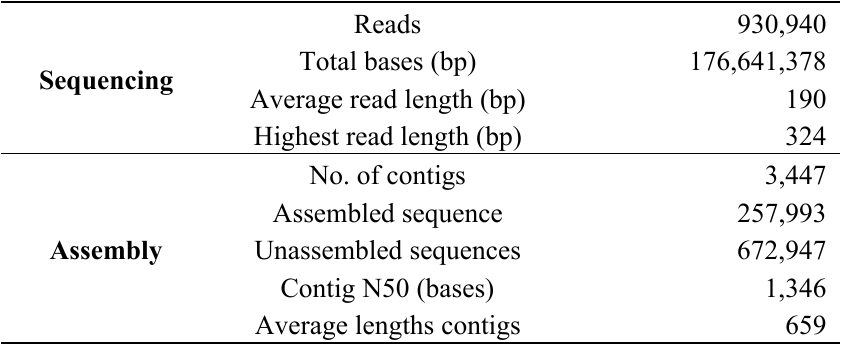
Table 2. Summary of PGM™ sequencing and assembly.